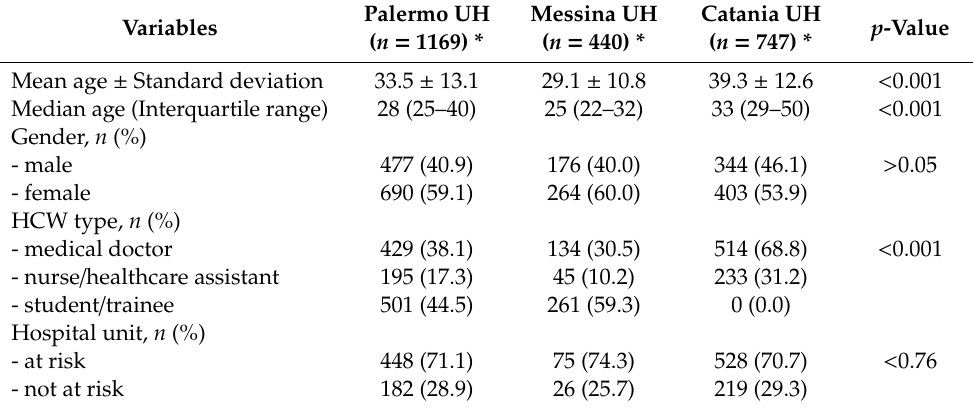
Table 1. Univariate analysis of the socio-demographics and working characteristics of healthcare workers (HCWs) vaccinated against influenza at the three Sicilian University Hospitals (UHs) ( n = 2356).